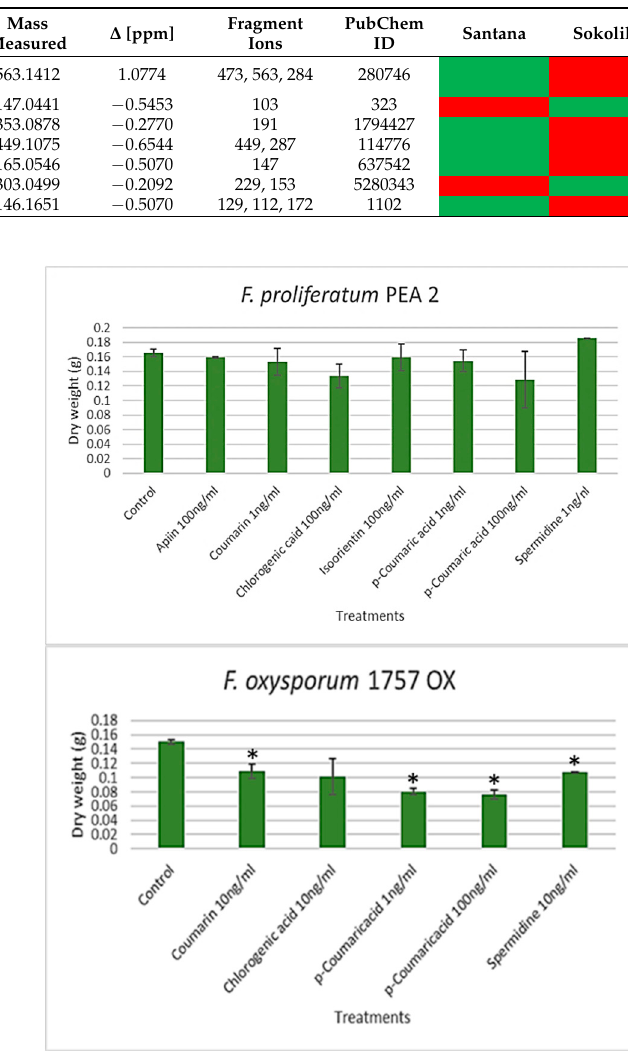
Table 2. Identification characteristics of the selected metabolites found differentially present in the extracts of Santana and Sokolik. (red color denotes higher quantities of the metabolite, green color denotes lower quantities of the metabolite).